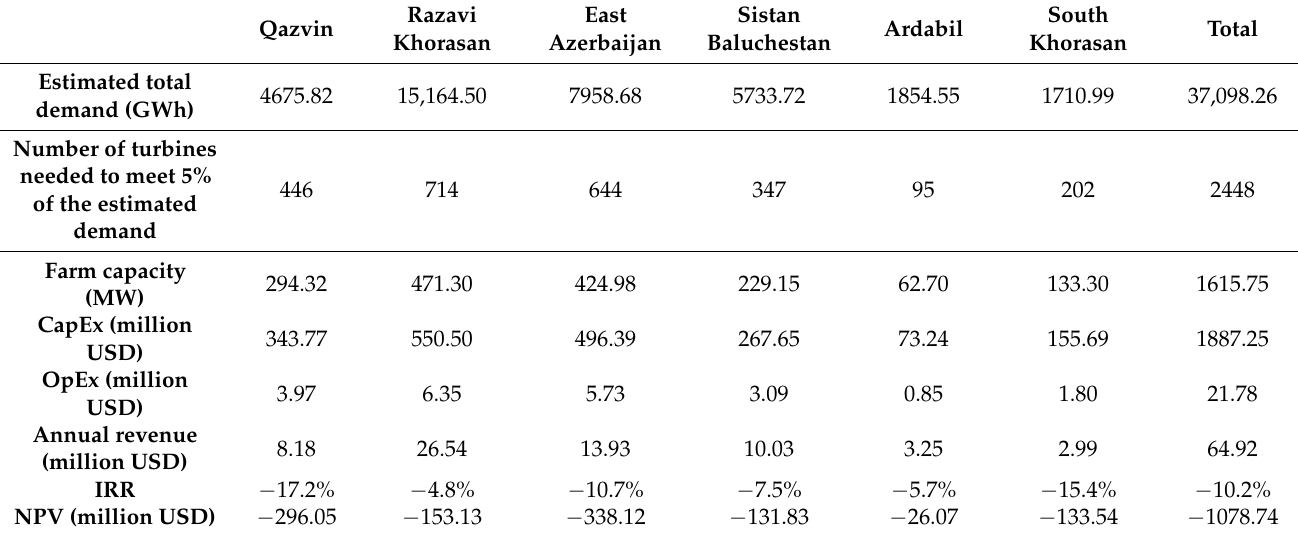
Table 4. Financial analysis of wind power for provinces with high wind potentials for a PPA of 20 years and a FiT of 3.5 cents per